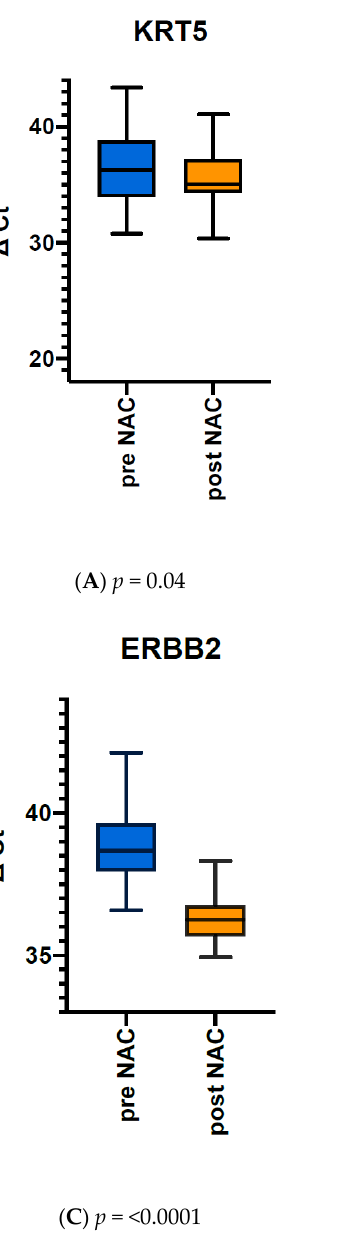
Figure 2. ( A ) KRT5, ( B ) KRT20, ( C ) ERBB2 and ( D ) ESR1 mRNA expression ( Δ CT) in MIBC patients before (blue) and after neoadjuvant chemotherapy (post NAC in orange). KRT20 expression decreases significantly after NAC. 3.5. Elevated KRT20, ERBB2 and ESR1 Expression before NAC Correlate with pCR in MIBC Tumours The mean expression of KRT20 in MIBC tumours of patients with pCR was 37.09 Δ Ct (IQR 5.39 Δ Ct, median: 39.15 Δ Ct (min: 25.32 Δ Ct, max: 42.74 Δ Ct)), that in tumours without pCR was 35.6 Δ Ct (IQR: 7.05 Δ Ct, median: 37.58 Δ Ct (min: 19 Δ Ct, max: 40.68 Δ Ct), Figure 3). The mean expression of ESR1 in tumours showing pCR after NAC was